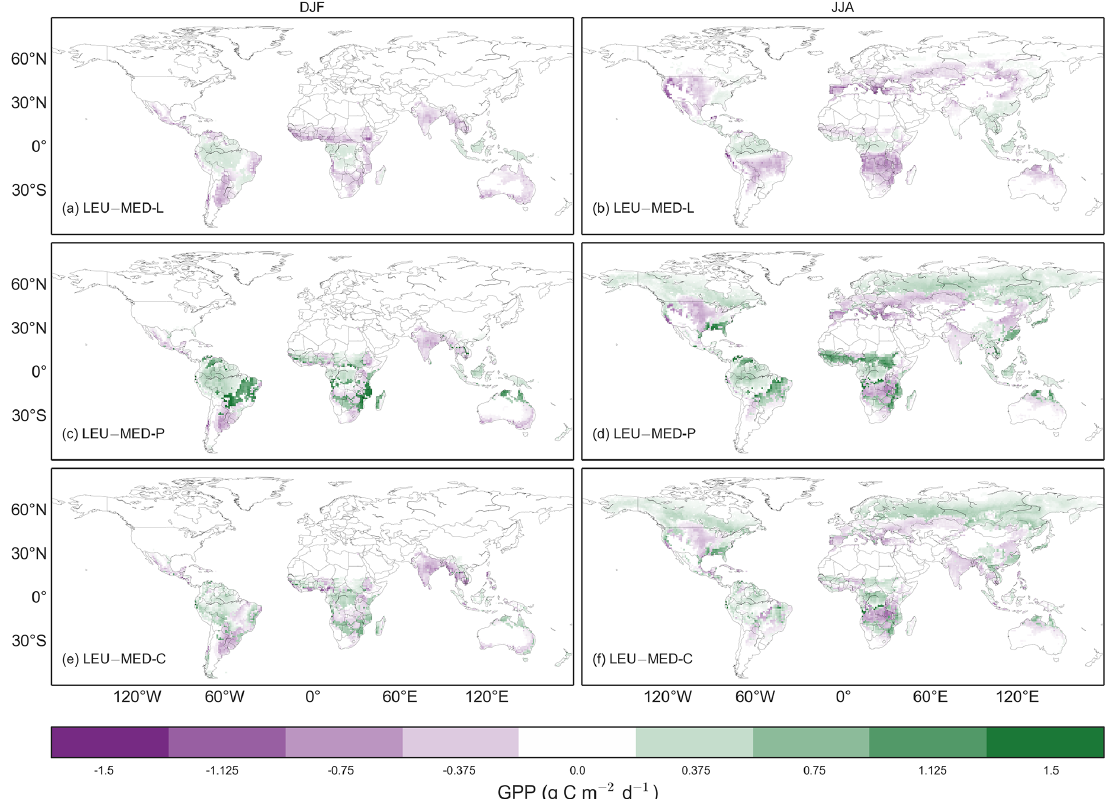
Figure 7. Mean seasonal (December-January-February: DJF and June-July-August: JJA) difference maps of gross primary productivity (GPP) calculated across the 10 years of the Global Soil Wetness Project2 (GSWP-2) forcing (1986–1995) period. Panels (a) and (b) show the difference between the standard CABLE (LEU) model and the Medlyn model fit to the Leuning model (MED-L), panels (c) and (d) show the difference between the LEU model and the Medlyn model with the g 1 PFT parameterisation (MED-P), and finally, panels (e) and (f) show the difference between the LEU model and the Medlyn model with the g 1 parameter predicted as a function of climate indices (MED-C). In total, 126 out of a possible 54000 pixels have been masked from panels (e) and (f) , representing pixels where the temperature range and moisture index extended outside the range of the synthesis g s database. Data shown in panels (b) , (c) , (d) , (e) , (f) have been clipped, with the maximum ranges extending to ( − 1.6 to 0.36), ( − 1.28 to 3.03), ( − 1.19 to 3.82), ( − 1.2 to 2.9) and ( − 1.05 to 3.7) and this affects 1, 64, 34, 42 and 147 pixels,